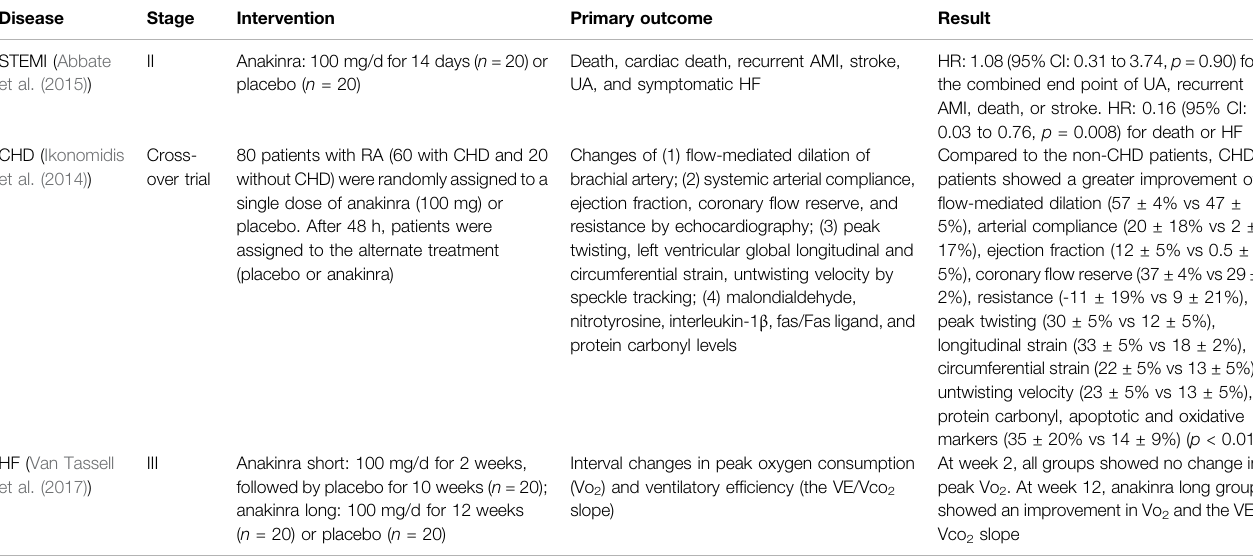
TABLE 1 | Clinical trials of anakinra. Disease